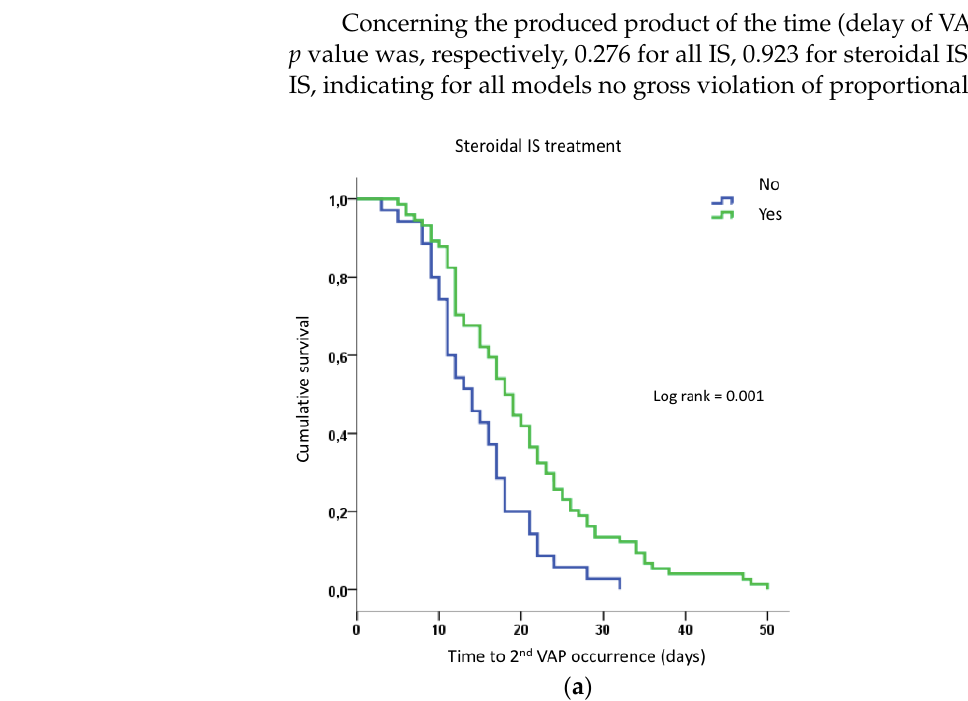
( b ) Figure 3. ( a ): Cumulated survival probability before 2nd VAP occurrence according to the use of steroidal IS treatment (subjects were censored at the time of VAP recurrence). ( b ): Cumulated sur-